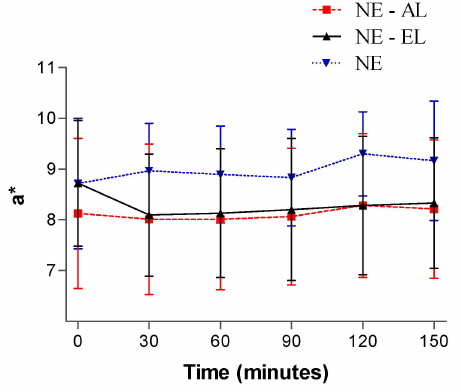
Figure 15. Colorimetric results in function of time after nanoemulsion